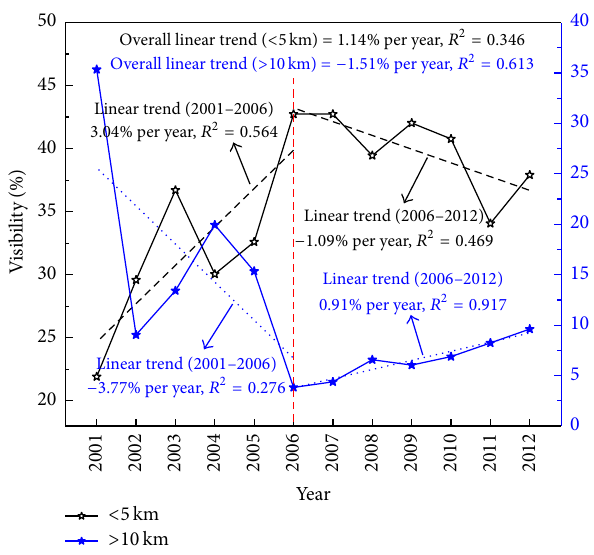
Figure 6: Annual region-average percentages (%) of visibility lower than 5 km (left 𝑦 -axis) and higher than 10km (right 𝑦 -axis) in Hefei during 2001–2012. Black dashed lines and blue dotted lines are the linear regression curves of the corresponding trend lines, splitted by year 2006 (the red short dashed